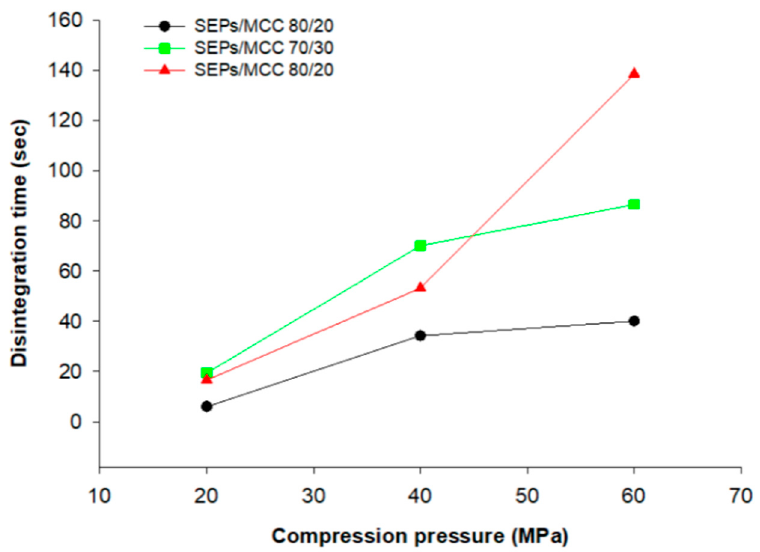
Figure 10. Plots of disintegration time against compression pressure for different SEPs/MCC ratios (80/20 black circles, 70/30 green squares, 60/40 red triangles).